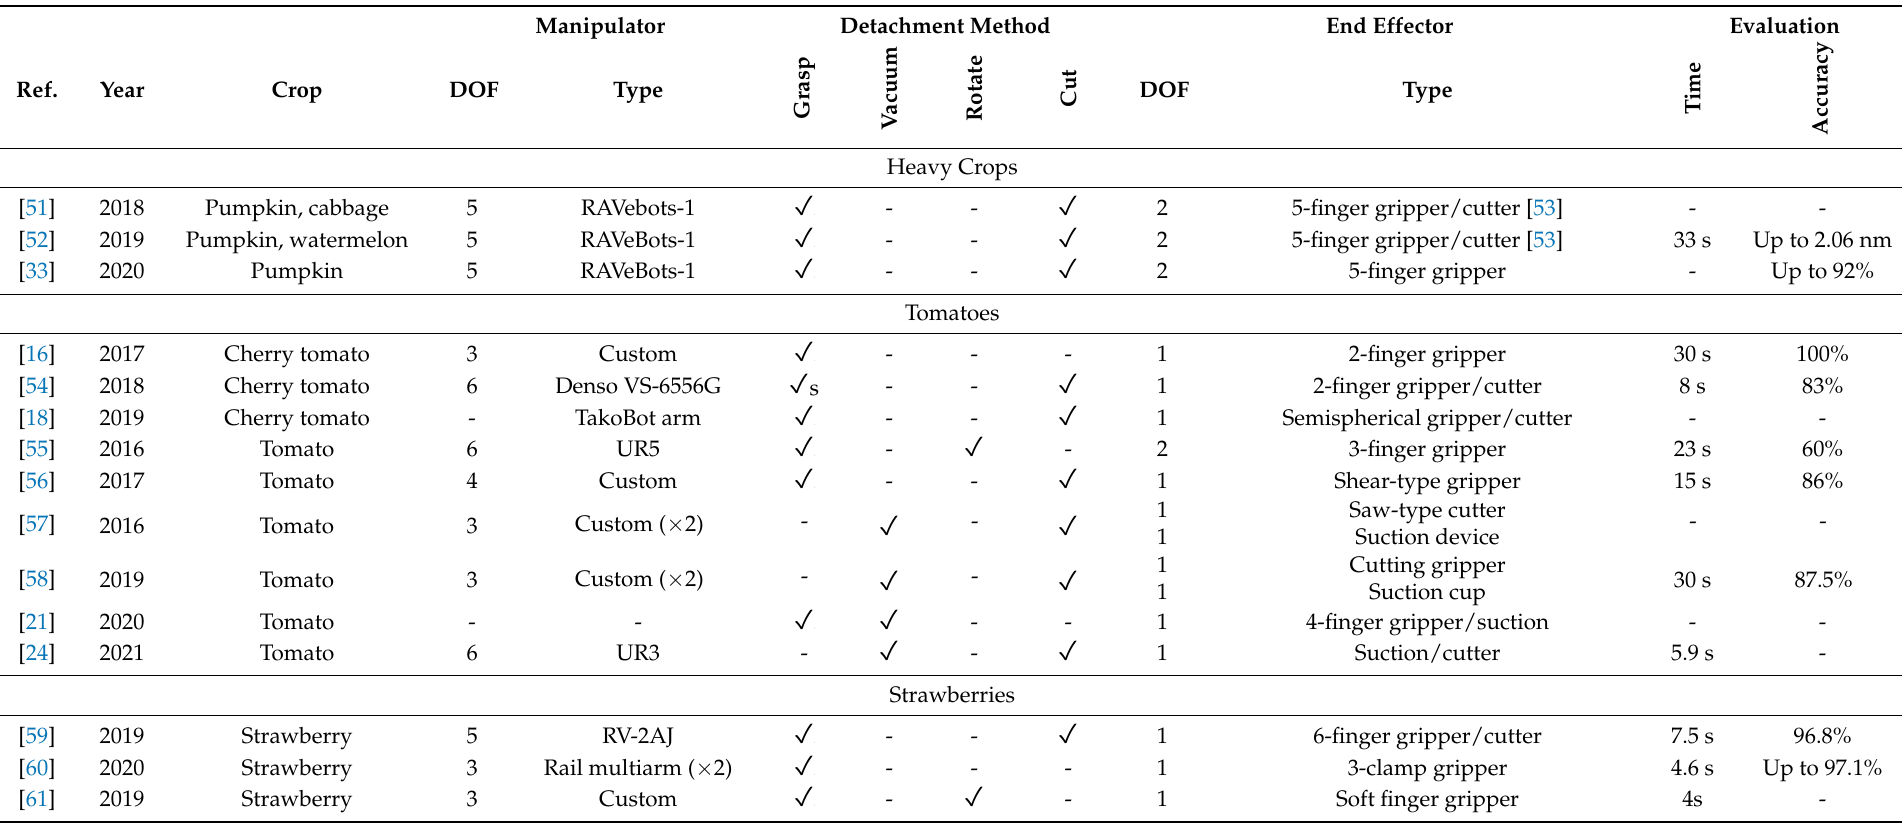
Table 1. Ground robotic manipulation systems for harvesting. Evaluation metrics of harvesting cycle time (time) and detachment success rate (accuracy) are included. Grasping from the stem is marked with “ ✓ s”; all other cases refer to direct contact grasping of the fruit.